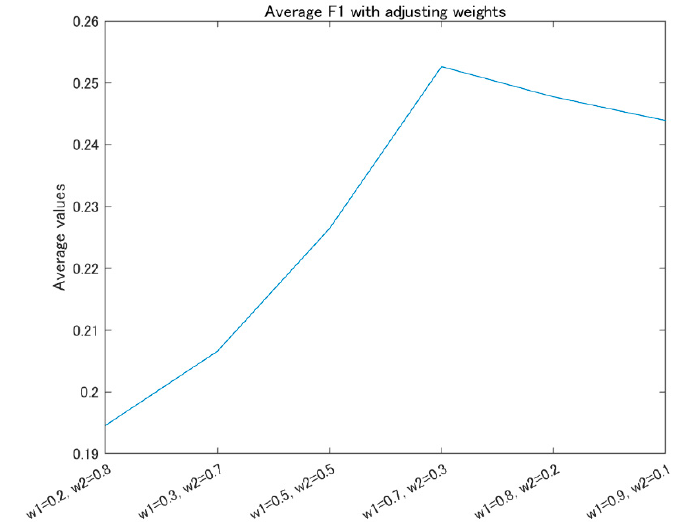
Figure 7. Average F1 with adjusting the weights.